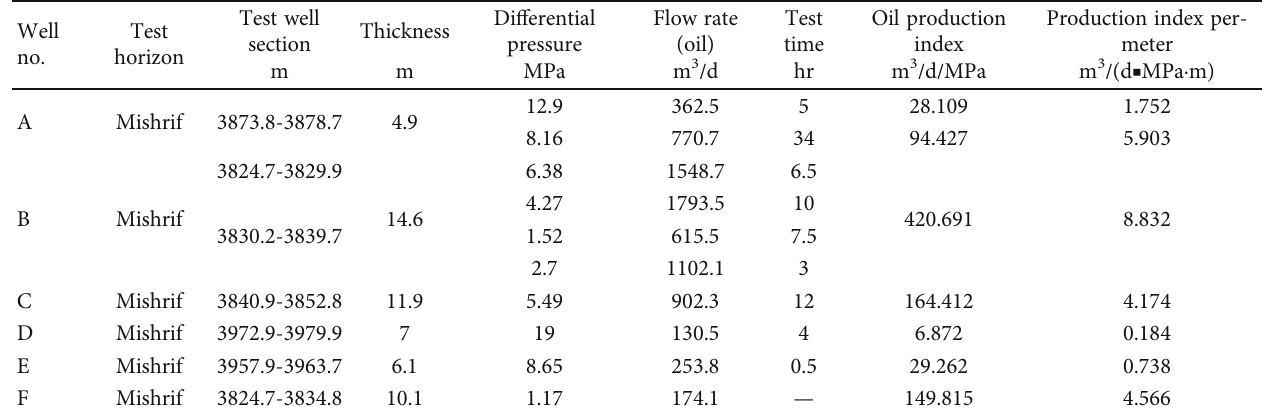
Table 1: Formation test results of oil fi eld.